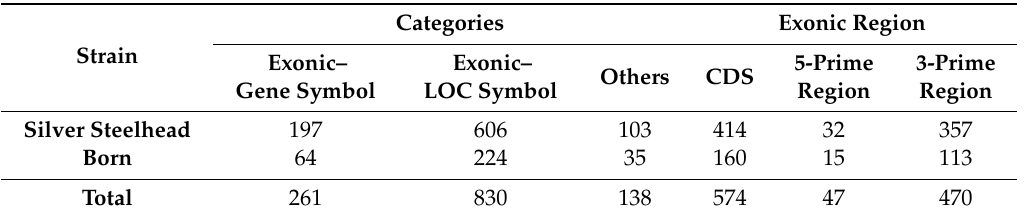
Table 2. Number of putative SNPs over all tissues and individuals according to heterozygosity, genomic regions and transcript regions.